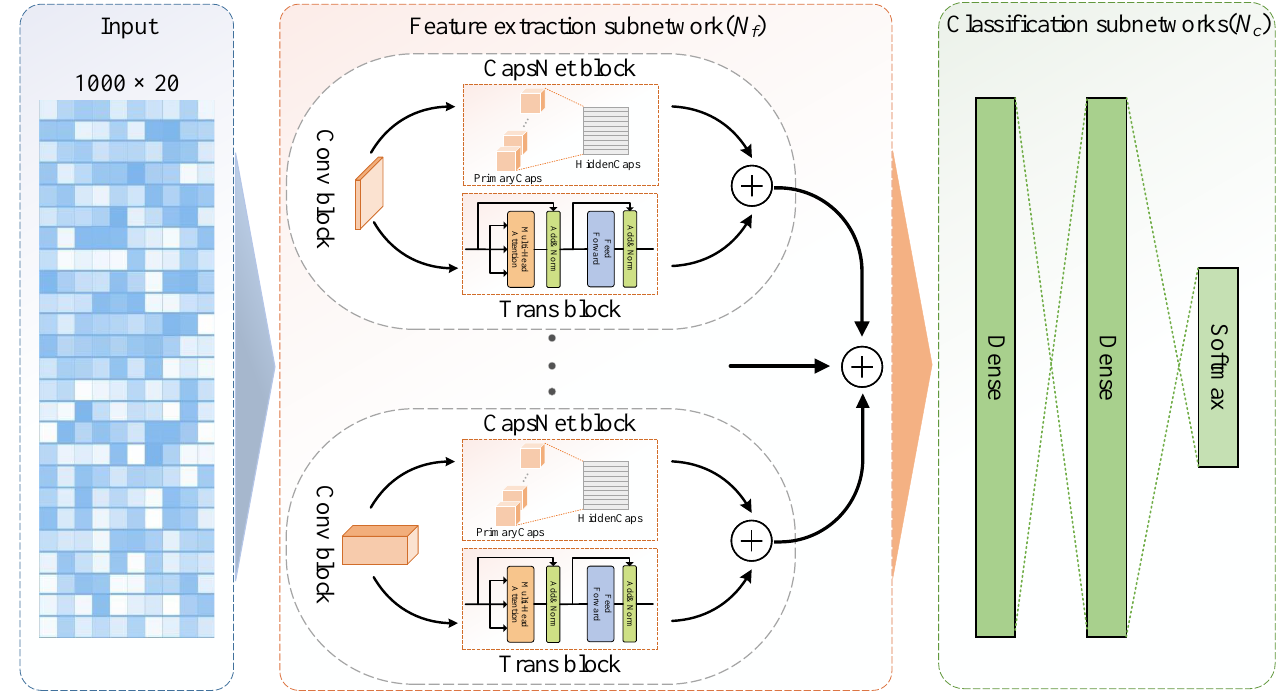
Figure 5. Architecture of the proposed